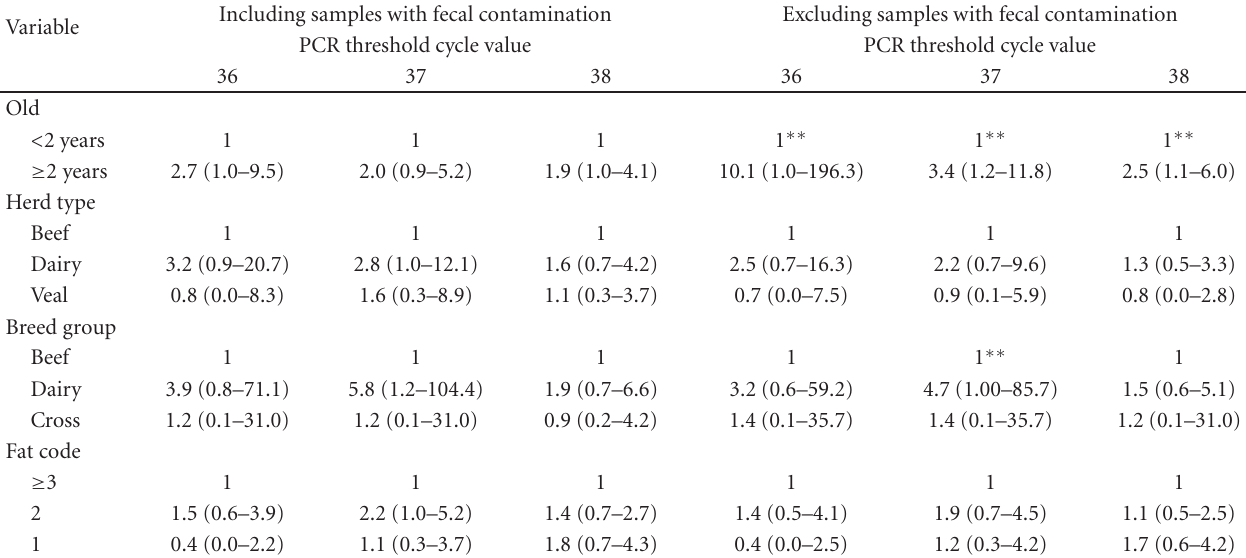
Table 3: Odds ratios (OR) and 95% confidence interval in parenthesis resulting from univariable logistic regression of risk factors for occurrence of Mycobacterium avium subsp. paratuberculosis DNA in beef carcasses.